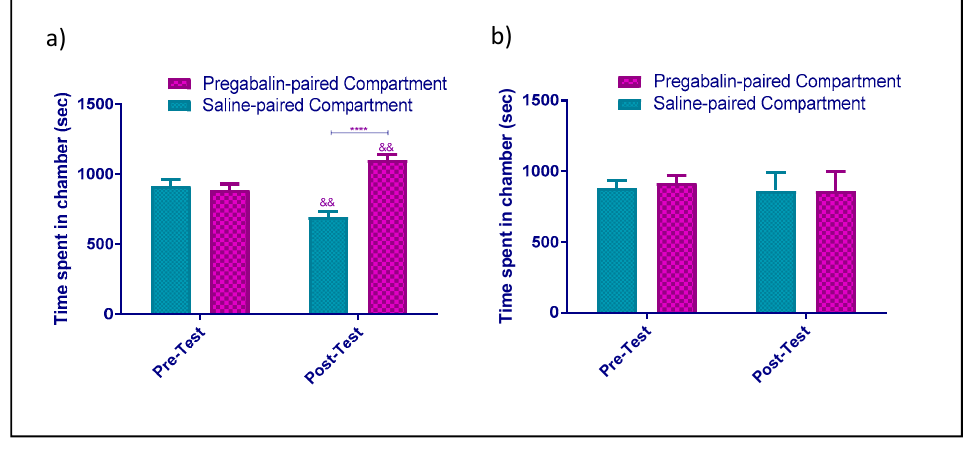
Figure 3. ( a ) Effect of pregabalin (60 mg/kg) on CPP. Time spent in pregabalin-paired compartment was significantly higher than that spent in the vehicle-paired compartment in the post-test. Time spent was significantly increased in the pregabalin-paired compartment post-test when compared to the saline and pregabalin-paired compartment pretest. ( b ) Effect of NAC-pretreatment on pregabalin-induced CPP. Time spent (mean ± SEM) was not significantly changed in pregabalin-paired compartment as compared to the vehicle-paired compartment pre- and post-test. ****: p < 0.0001; (&&: p < 0.01).